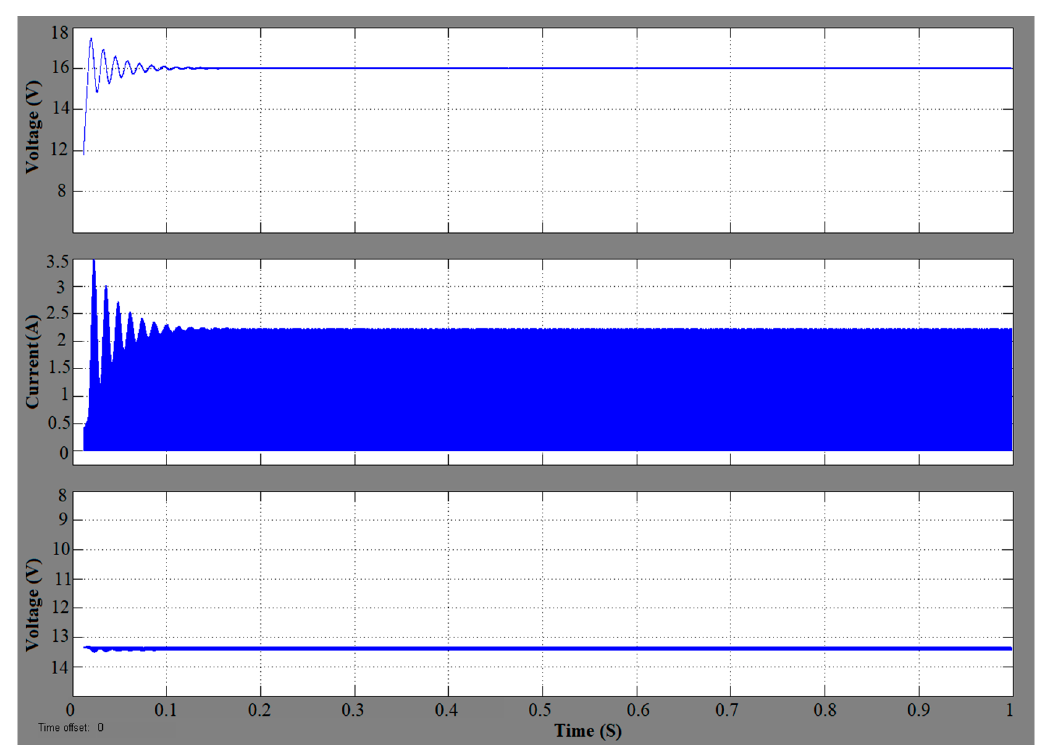
Figure 8. Simulation output of the buck–boost converter.